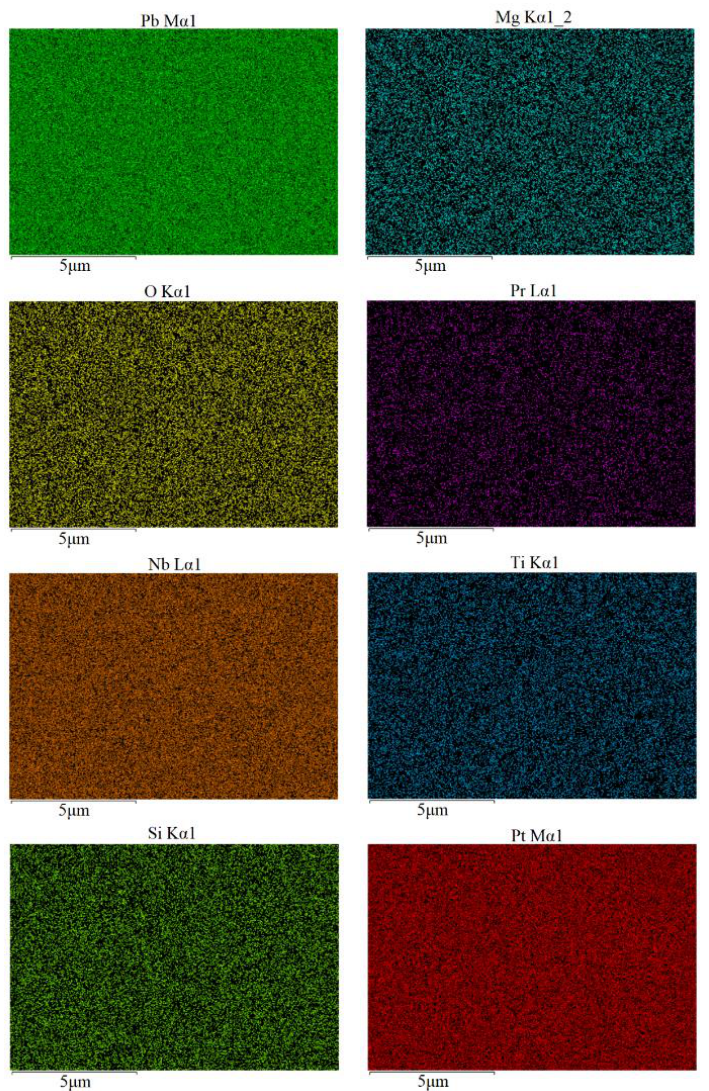
Figure 3. Element mapping of 2.5% Pr-PMN-PT thin films annealed at 650 °C for 2 min.